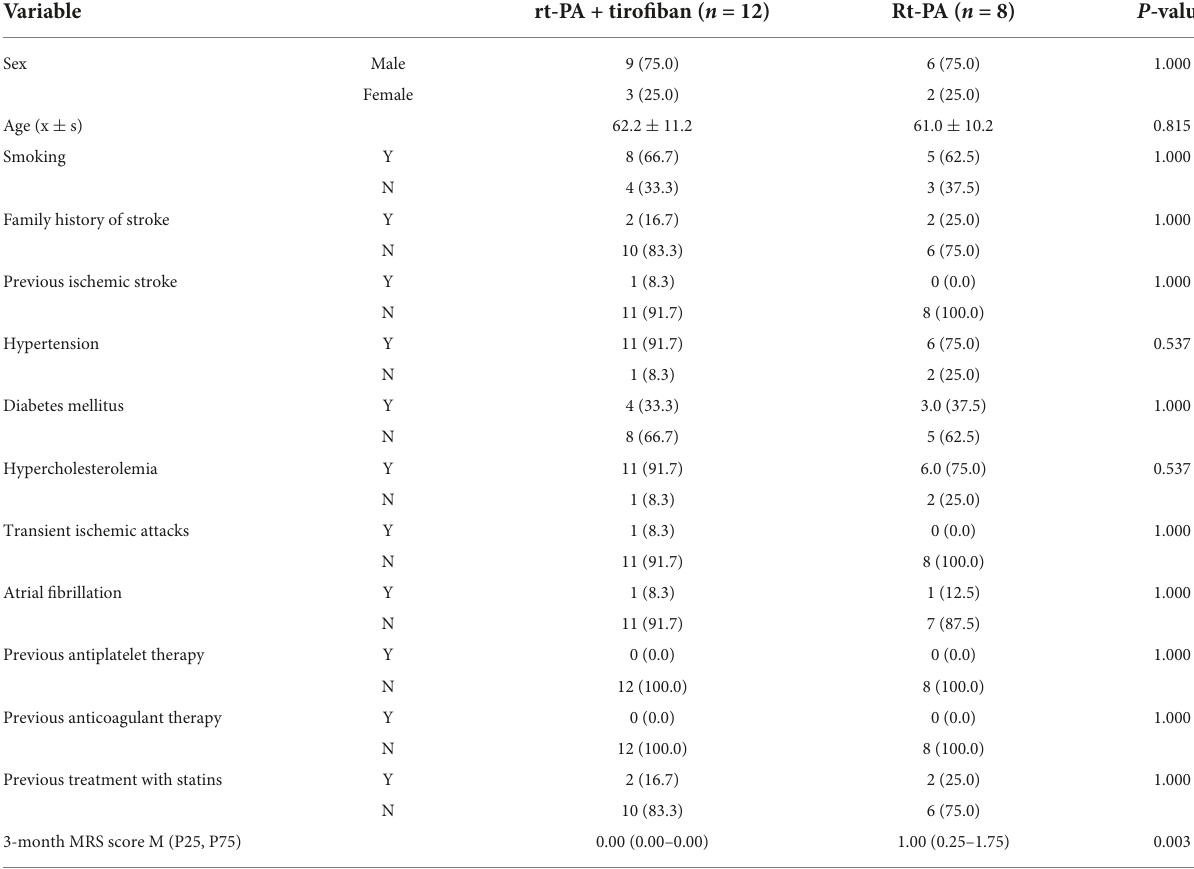
TABLE 1 Comparison of clinical baseline data and modified Rankin Scales (MRS) score between recombinant tissue plasminogen activator (rt-PA) treatment and recombinant tissue plasminogen activator (rt-PA) combined with tirofiban groups, n (%).